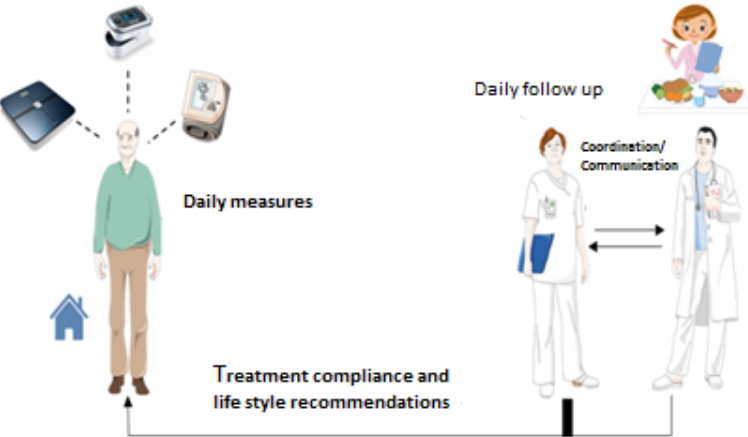
Figure 1. The USICAR ( Unité de Suivi des Patients Insuffisants Cardiaques ) HF (Heart Failure) unit is aimed at optimizing the management of HF patients, especially those recently hospitalized for cardiac decompensation. The team of the unit is composed of three cardiologists, two nurses, one dietitian, and one secretary. The unit ensures a regular personalized follow-up and therapeutic education of heart failure patients, as well as the coordination with the other healthcare professionals involved in the management of each patient. A remote monitoring solution was used in all patients likely to use it.